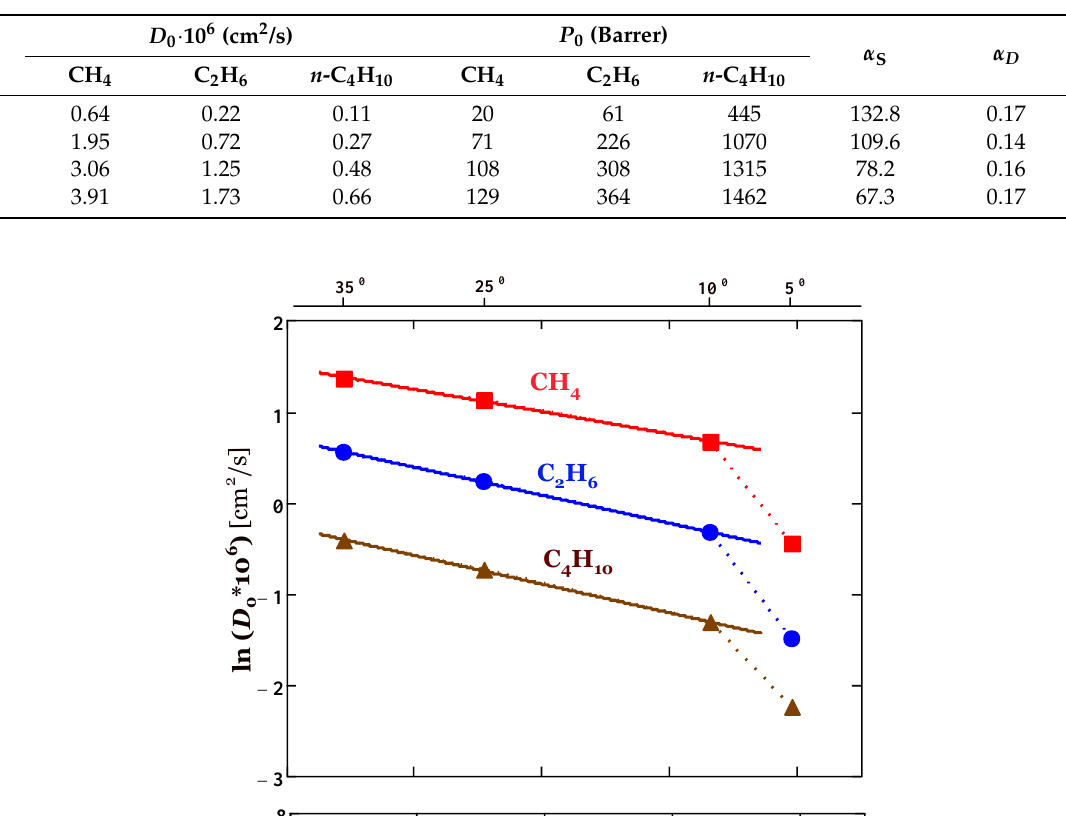
(open symbols). The permeability values obtained by the sorption method are somewhat higher (by 10 – 20%) compared to the steady-state permeability measurements. Possible